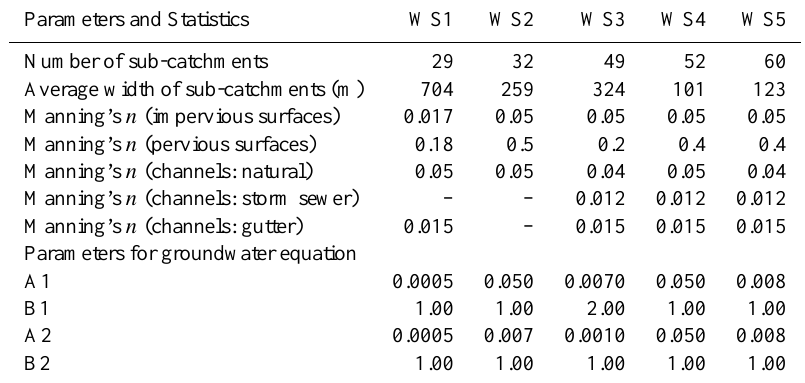
Table 3. Calibrated SWMM model parameters for five watersheds (WS1 to WS5) in central Iowa. A1, B1, A2, and B2 are coefficients for the groundwater equation in